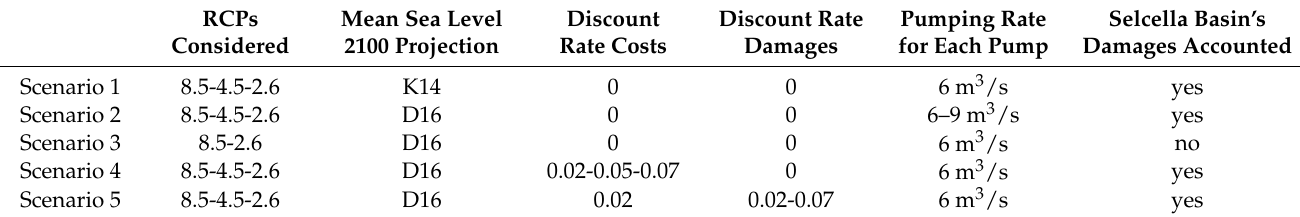
Table 2. Scenarios description.